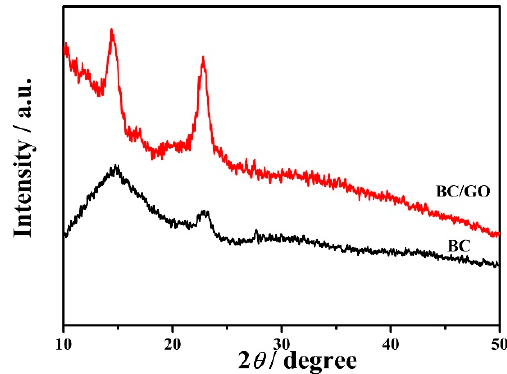
Figure 4. X-ray diffraction patterns of pure BC and BCGO.